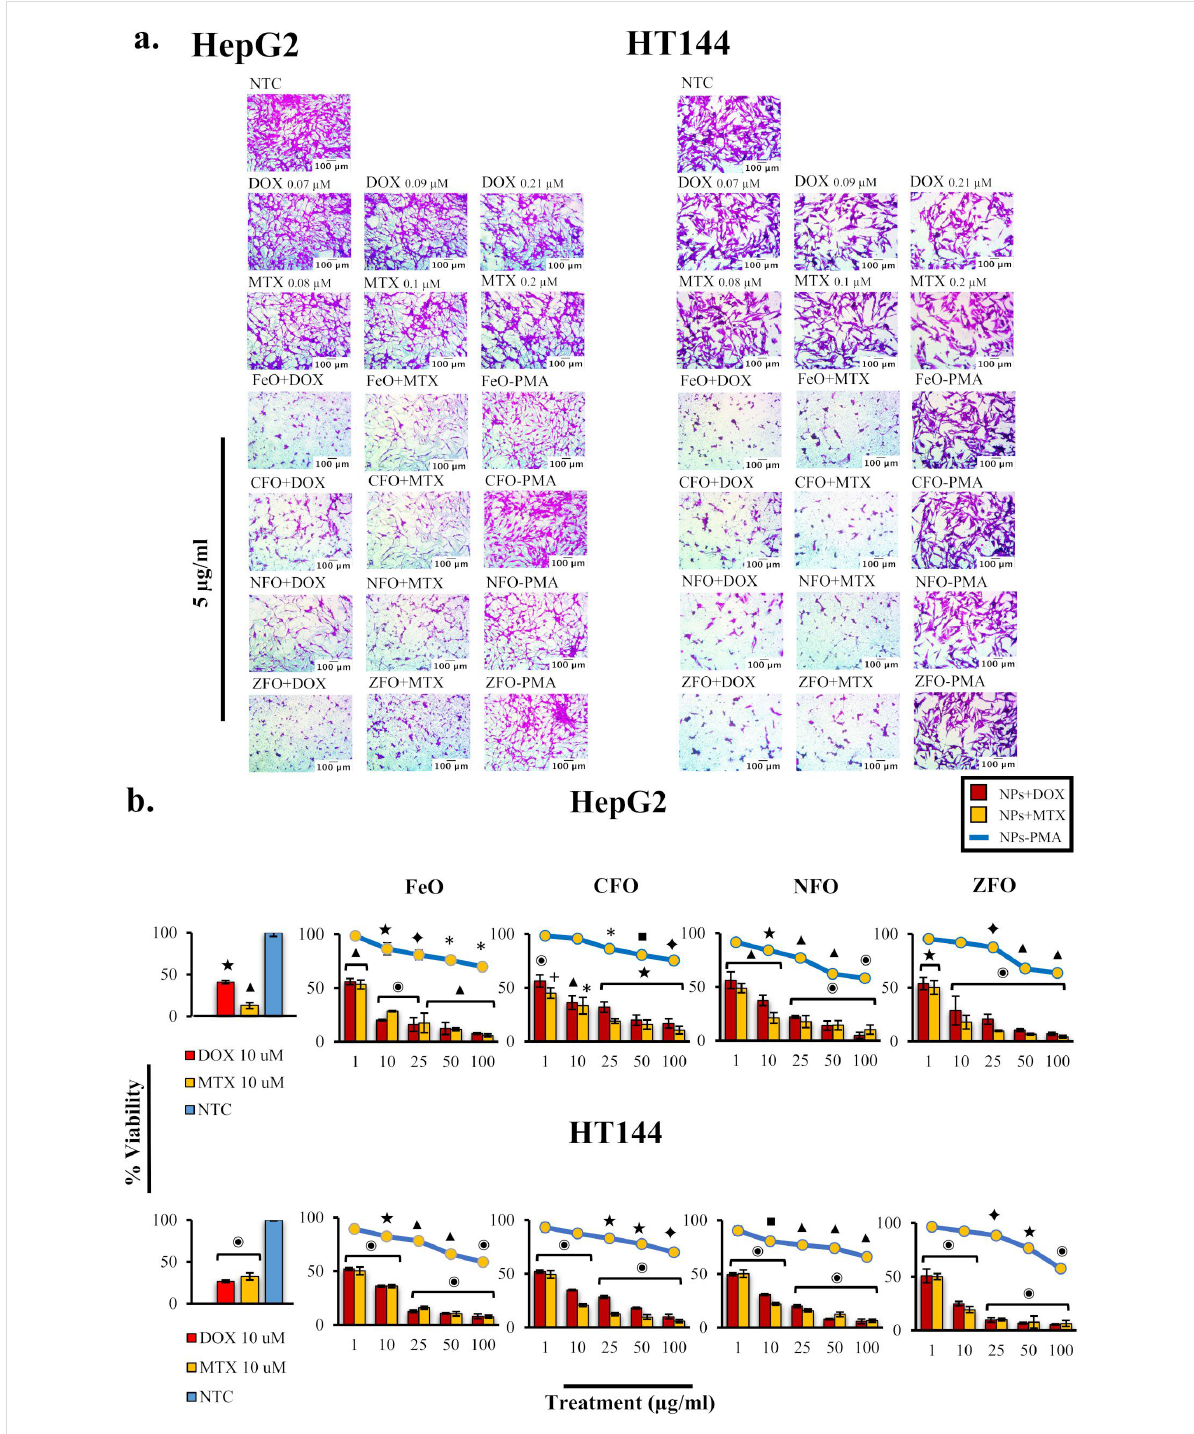
Figure 4: (a) Microscopy images of HepG2 and HT144 cells treated with drug-loaded (DOX and MTX) MFe 2 O 4 (M = Fe, Co, Ni, Zn) NPs at a 5 μ g/mL dose, for 24 h. For comparison, free drug controls were included, which represented the total drug amount attached to NPs at different dosages (DOX = 0.08, 0.21, 0.09, and 0.09 μ M; MTX = 0.08, 0.2, 0.1, and 0.1 μ M respectively). Nontreated controls and PMA-coated samples (NPs-PMA) were also included as controls (5 μ g/mL). Magnification = 200×, scale bar = 100 μ m. (b) Dose-dependent cytotoxicity of HepG2 and HT144 cells treated with NPs+drugs and NPs-PMA (1, 10, 25, 50, and 100 µg/mL) for 24 h. Controls included free DOX and MTX (10 μ M each) and NTC. Plotted data indicates mean ± SD of independent triplicates. p < 0.05 (one asterisk), p < 0.01 (black square symbol), p < 0.005 (black diamond symbol), p < 0.001 (black star symbol), p < 0.0005 (black triangle symbol), and p < 0.0001(circled bullet symbol), paired two-tailed t -test when samples were compared to